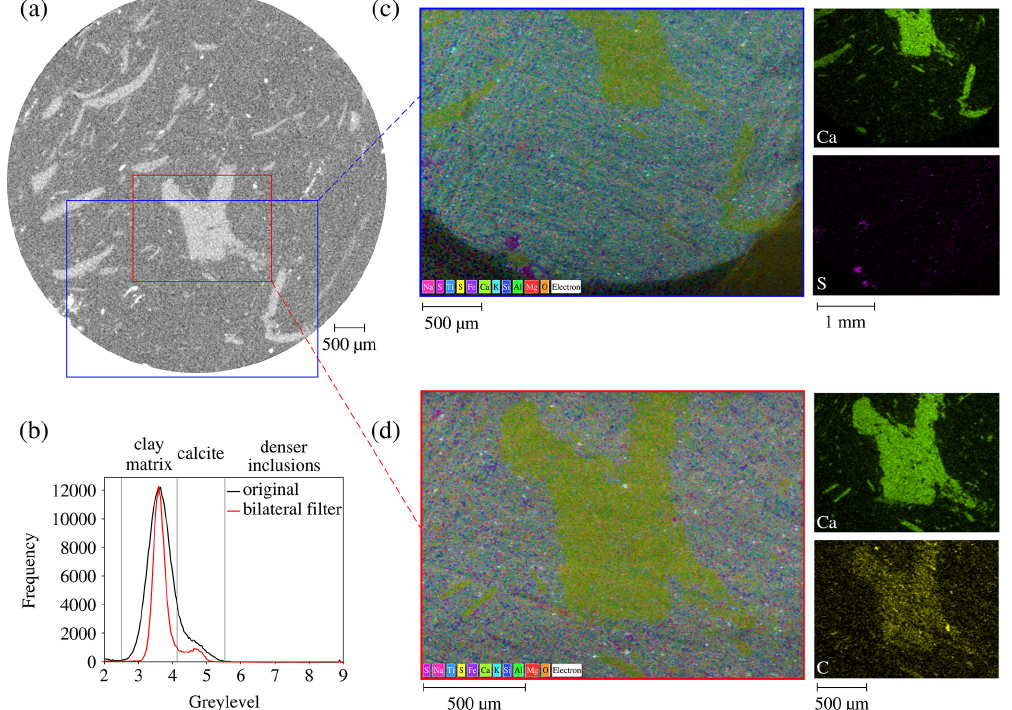
Figure 2. Identification of the inclusions’ mineralogy combining X-ray tomography and SEM–EDX: (a) horizontal X-ray tomography slice, (b) histogram of GVs of the top horizontal slice, (c) SEM–EDX map corresponding to the blue window of the X-ray slice highlighting all identified elements and the areas rich in Ca and S, (d) SEM–EDX map corresponding to the red window of the X-ray slice highlighting all identified elements and the areas rich in Ca and